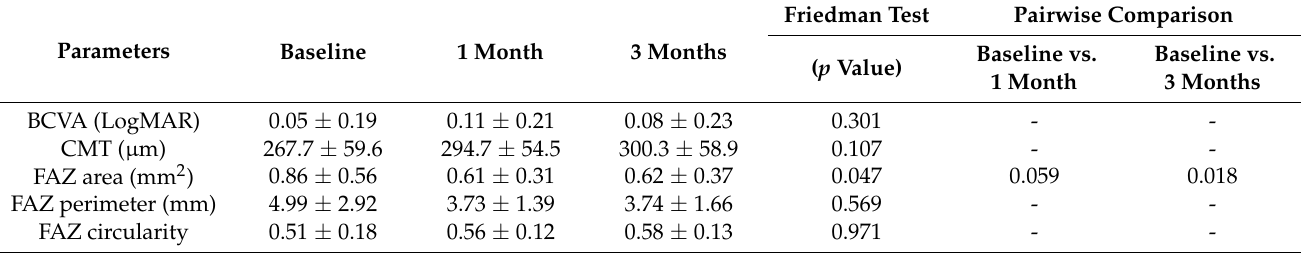
Table 4. Summary of the DMI group results and comparison of the baseline and post-panretinal photocoagulation measurements.